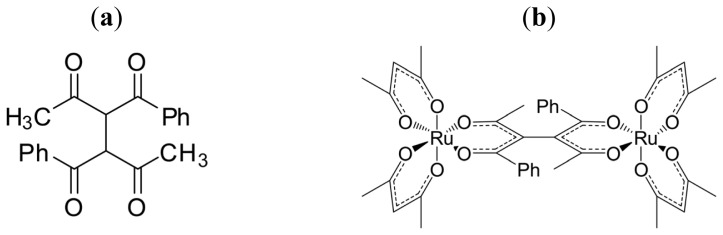
Structures of (a) 1,2-diacetyl-1,2-dibenzoylethane (dabeH2) and (b) [Ru(III)(acac)2(dabe)Ru(III)(acac)2] (modified from [21]).